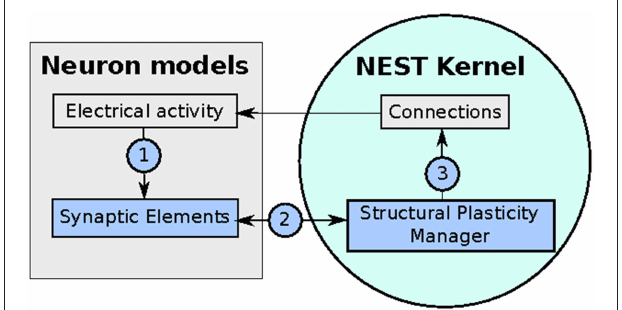
FIGURE 2 | Diagram of the implementation of the structural plasticity model in NEST. In (1) the number of synaptic elements is calculated depending on the electrical activity of the neuron. These calculations are optimized using MPI and OpenMP. In (2) the structural plasticity manager gathers the number of synaptic elements per neuron using MPI directives and in (3) creates or deletes synapses to update the connections between neurons using MPI and